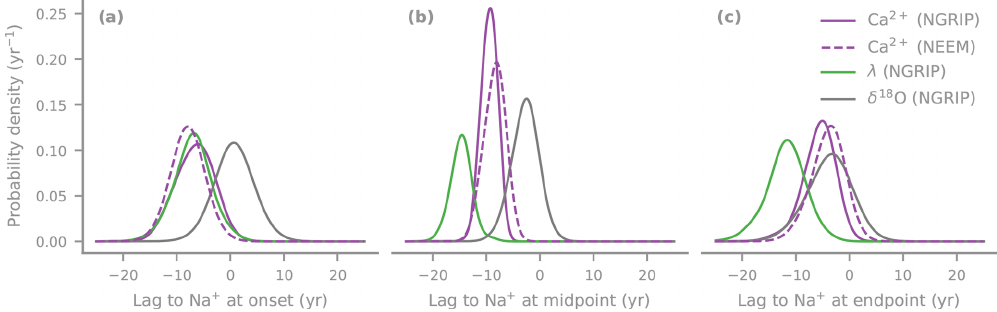
Figure 4. Combined probability density estimates of the lag of the Ca 2 + , layer thickness and δ 18 O transitions relative to the respective point in the Na + records for the onset (a) , midpoint (b) and end (c) of all transitions from stadial to interstadial for the two cores.